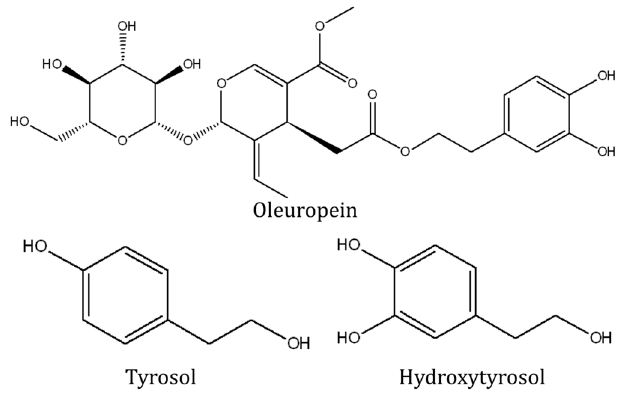
Figure 1. Chemical structure of oleuropein, tyrosol and hydroxytyrosol.